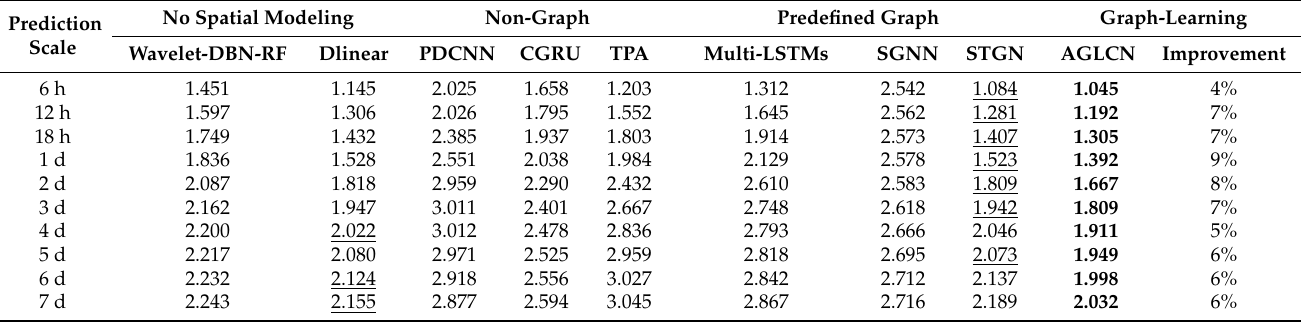
Table 3. MAE of forecasting methods for 120 nodes.